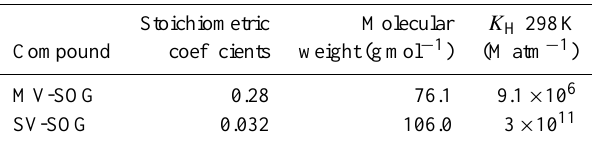
Table 1. Properties of medium- and semi-volatile secondary gases (MV-SOG and SV-SOG) based on Anttila et al. (2010). Note that the Henry’s law coefficient for MV-SOG has been increased by one order of